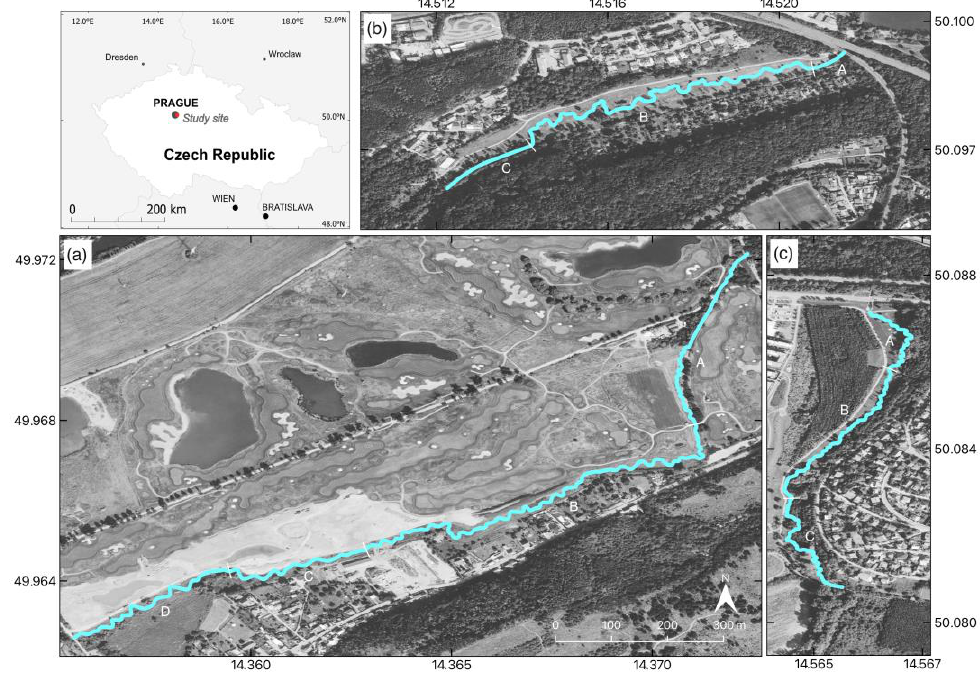
Figure 1. Study area. Restored streams of the ( a ) Lipanský (LIP) brook, ( b ) Rokytka (ROK) brook, and ( c ) Hostavický (HOS) brook in Prague, Czech Republic, with marked stream reaches used for the assessment of geometric properties.